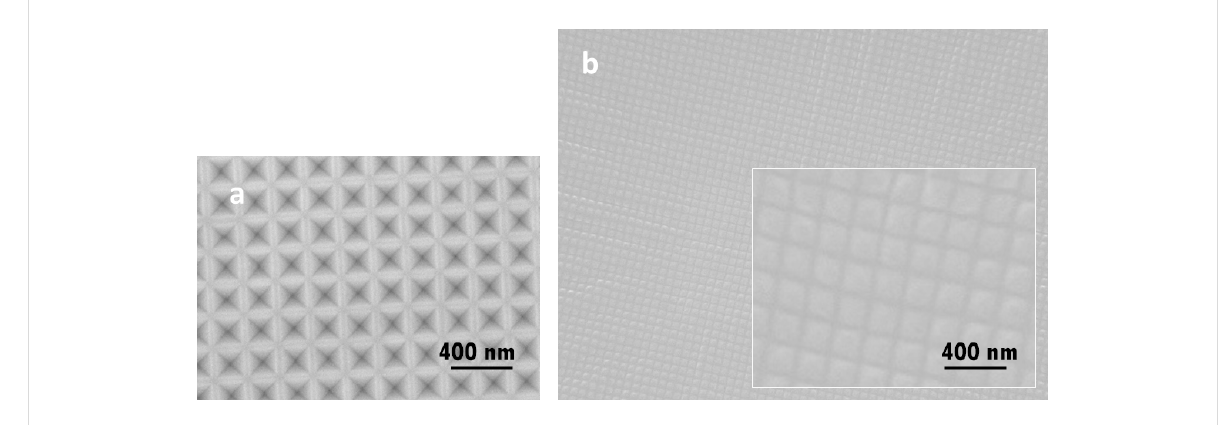
Figure 1: (a) Silicon master mold with inverted pyramidal pits and (b) PDMS stamp with the transferred pattern. The inset in (b) is a high-magnifica- tion image.